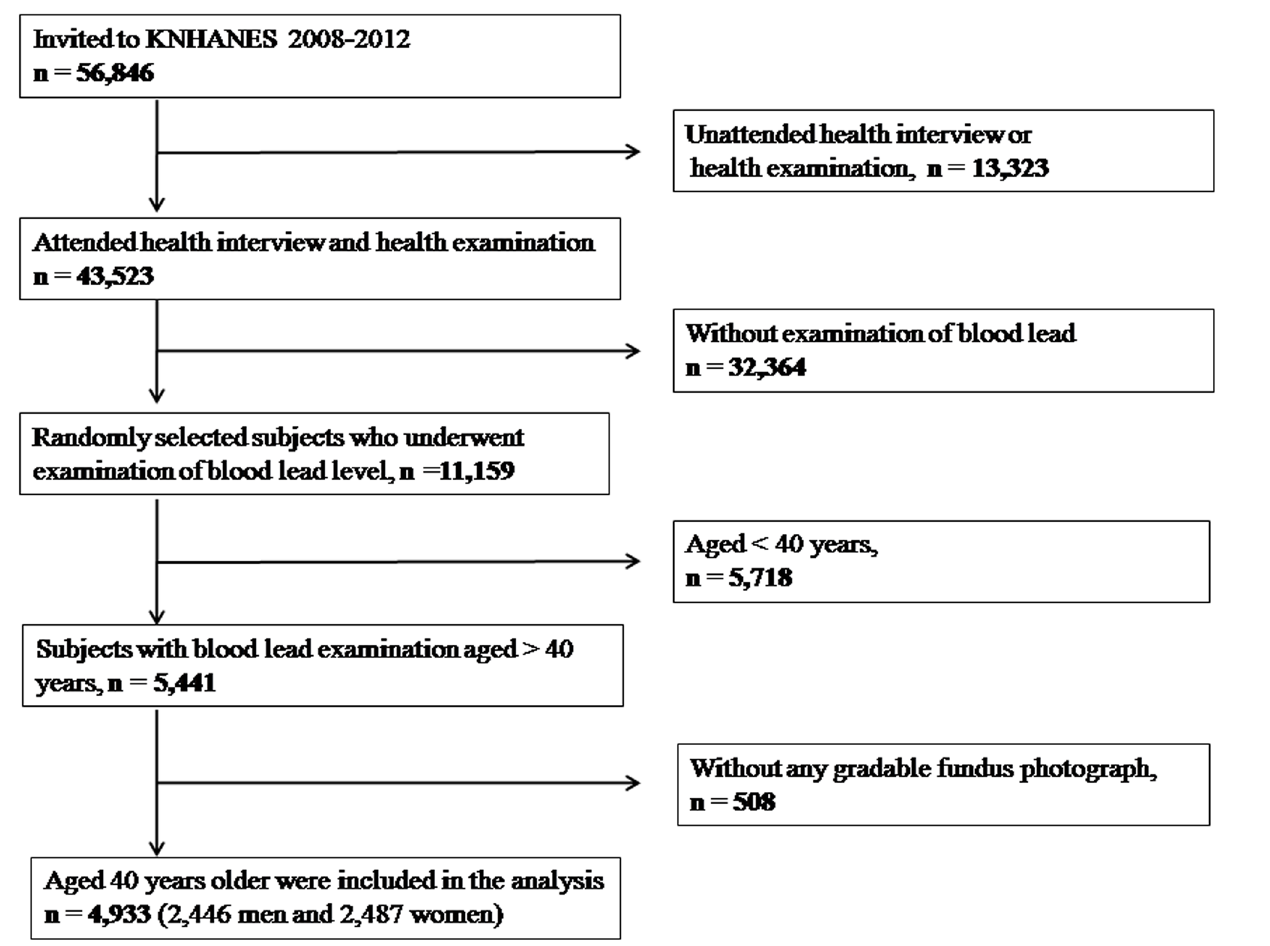
Fig 1. Flow diagram showing selection of study